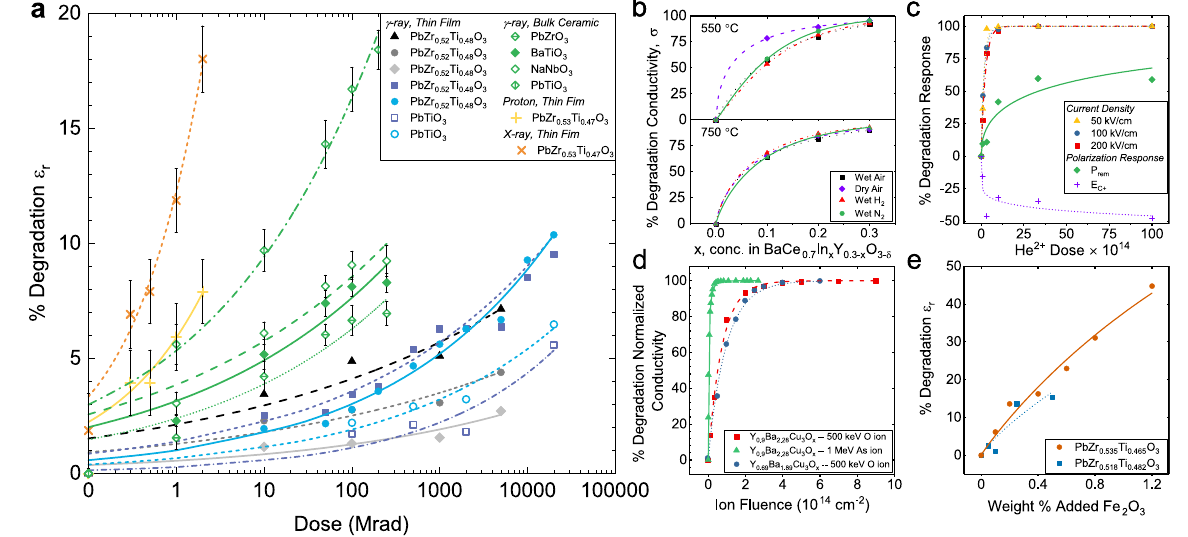
Figure 2. Application of the proposed model to previously-reported total ionizing dose (TID) studies in ferroelectrics and to dopant/radiation studies on various functional materials. ( a ) The effects of gamma, X-ray, and proton irradiation on the dielectric permittivity of various bulk and thin film ferroelectrics are shown. Data in gray/ black shows gamma dose rate studies 47 . Blue symbols indicate degradation of the dielectric permittivity at positive and negative coercive voltages for PZT and lead titanate 48 . Green symbols show experiments on bulk ferroelectrics performed 49 . X-ray and proton irradiation of PZT shown in orange and yellow symbols, respectively 39 . ( b ) Indium doping in BaCe 0.7 In x Y 0.3 − x O 3 −δ at different atmospheric conditions 28 . ( c ) He-ion implantation in epitaxial perovskite PbTiO 3 films 15 . ( d ) O- and As-ion irradiation of superconducting yttrium barium copper oxide (YBCO) 23 . ( e ) Fe 2 O 3 doping of ferroelectric lead zirconate titanate (PZT) 50 . All data reproduced with